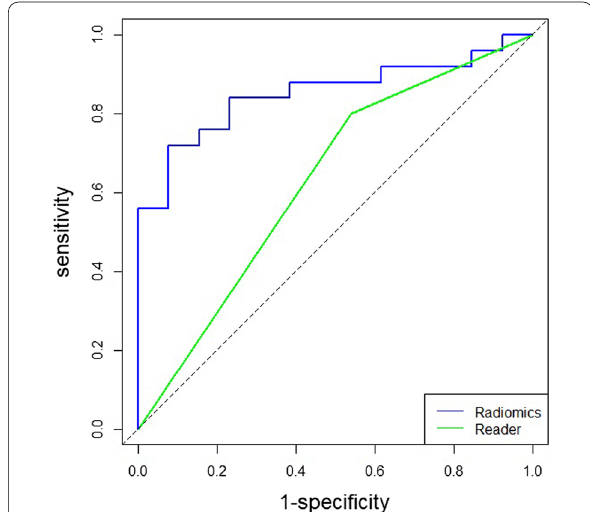
Fig. 4 Receiver operating characteristic (ROC) curves of the radiomics model and visual assessment by nuclear medicine radiologists for discriminating PCa and BPD in the test